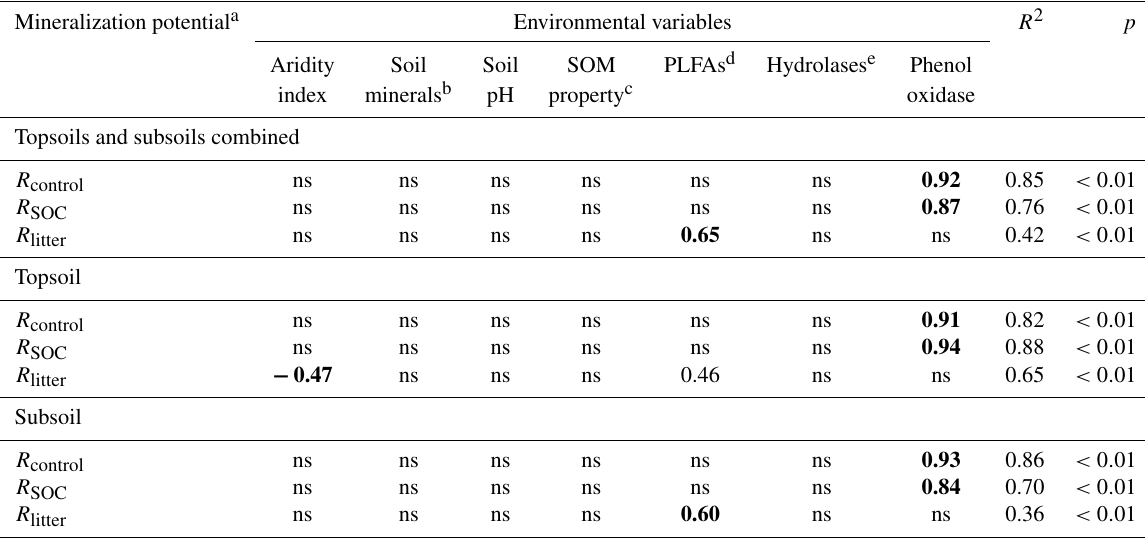
Table 5. Standardized partial regression coefficients of the multiple stepwise regression analysis for substrate mineralization potentials with environmental